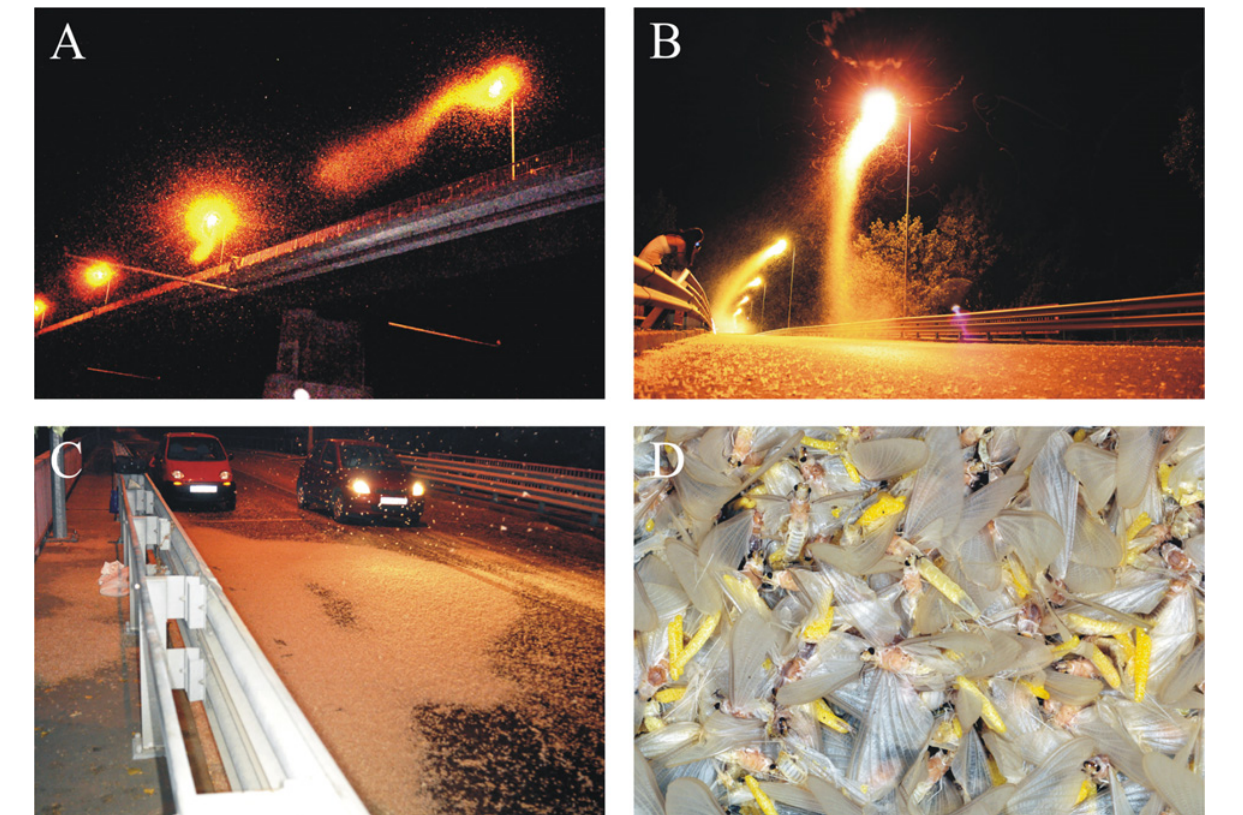
Fig 2. (A) Mass swarming of Ephoron virgo mayflies at night in Tahitótfalu (northern Hungary) at a bridge overarching the river Danube. (B) During the swarming we could observe that female mayflies performing their compensatory flight, flew up to the bridge-lamps. One part of females reaching the bridge landed on the asphalt road to oviposit, whereas the others joined to the swarm of several thousands individuals around the bridge-lamps. (C) With the progress of mass congregation the ovipositing females covered in greater and greater deal the asphalt road of the bridge. The mass of mayflies containing already perished and still ovipositing individuals formed large, extended, white stains. (D) The yellow egg batches are easy to recognise in the white crowd of mayflies, that consisted of several thousand eggs